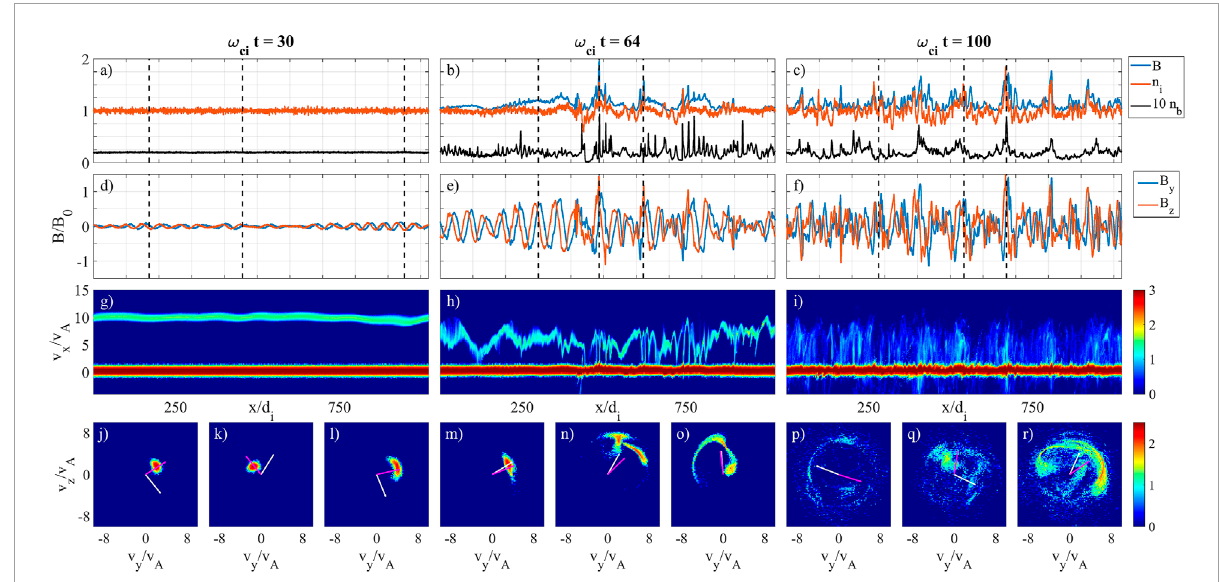
FIGURE 2 Results from 1D hybrid simulations of the resonant right-hand instability (RHI) with cold ( v thi = v thb = 0 . 1 v A ) ion populations. The left panels are at early time t ω ci = 30, middle panels are at t ω ci = 64, and right panels are at t ω ci = 100. (A–C) Background (red) and beam (black) ion density profiles and magnetic field strength (blue). (D–F) Wave magnetic field components B y and B z . (G–I) Parallel x − v x phase space distribution of the ions, showing the dense background at v x ∼ 0 and the beam with an Alfven Mach number of M A = 10. (J–R) Beam ion distributions in the perpendicular v y − v z plane at the points marked by the vertical dashed lines in (A–C) . The white lines show the direction of the perpendicular wave magnetic fields B y and B z , and the magenta lines show the direction of the bulk beam perpendicular velocity.